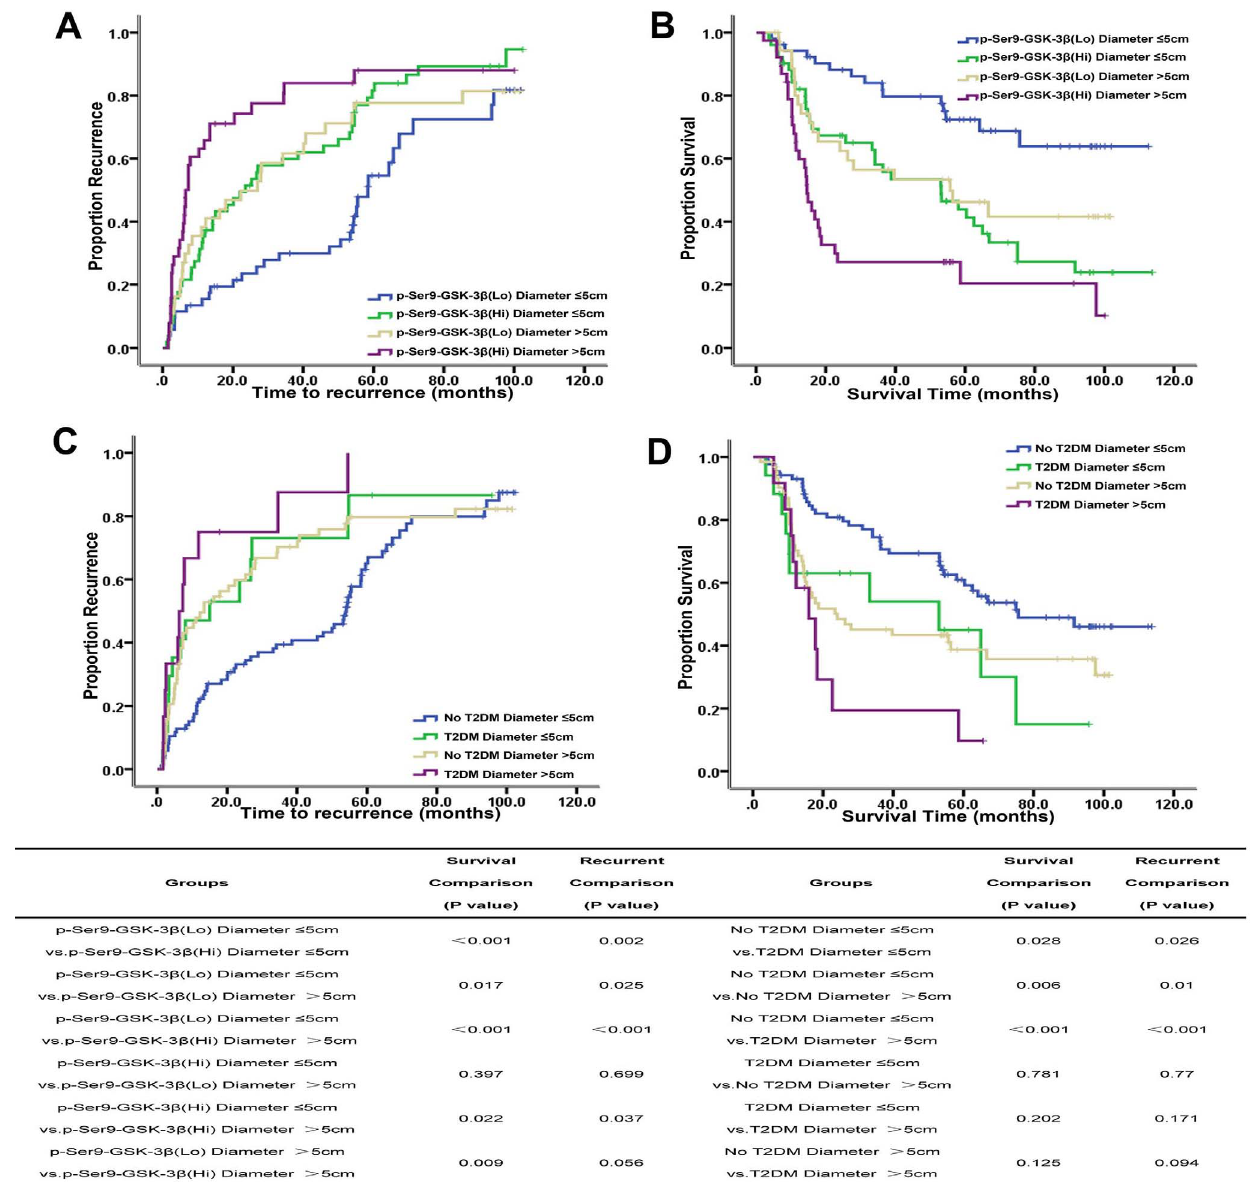
Figure 4. Kaplan-Meier analysis of TTR and OS stratified by tumor diameter of HCC patients. (A,B) Kaplan-Meier curves of the correlation between p-Ser9-GSK-3 b expression level, tumor diameter divided by 5cm and (A) recurrence or (B) overall survival of HCC patients; (C,D) Kaplan-Meier curves of the correlation between T2DM, tumor diameter divided by 5cm and (C) recurrence or (D) overall survival of HCC patients.